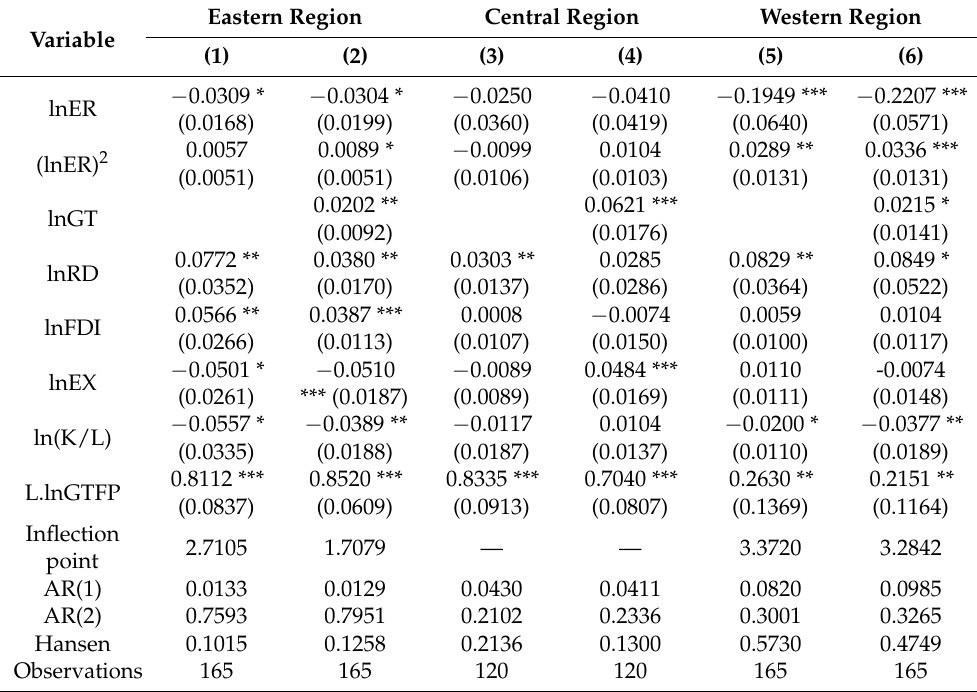
Table 4. Regression results of different regions with